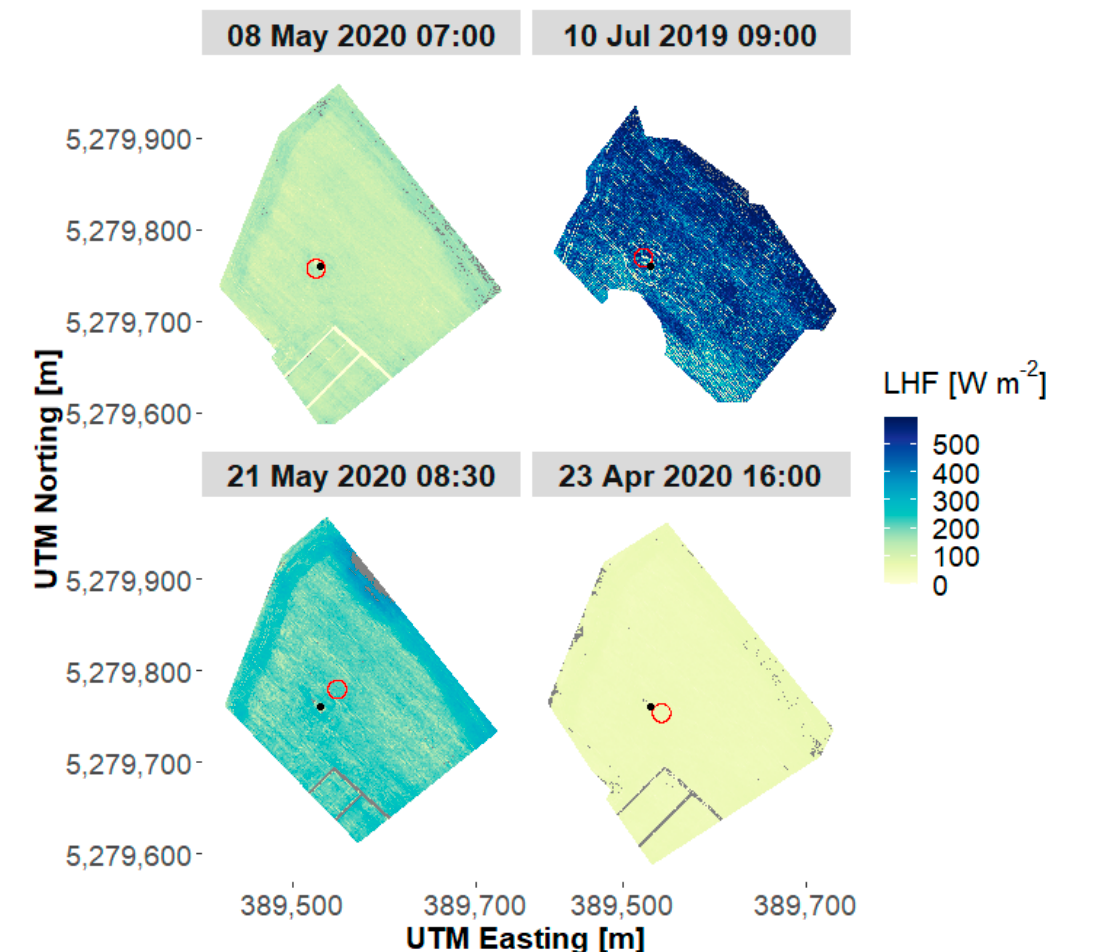
Figure A5. Latent heat flux maps of the cropland (Kartal) site in 2019 and 2020. The black dot indicates the position of the eddy-covariance tower, while the red circle indicates the footprint area from which the averages for validation were calculated.